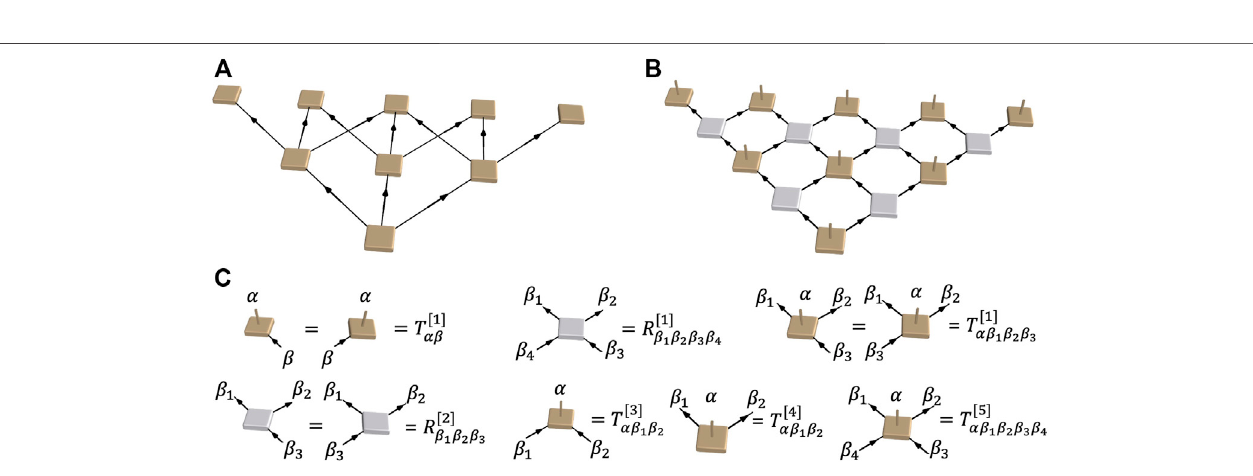
FIGURE 3 | Tensor network construction for open-pit mining problem. (A) Directed graph representation of the open-pit mining problem, with the excavatable blocksexpressed asnodes inlightbrown. (B) Acorrespondingtensornetworkconstruction, where thelightbrownblocks showthephysicalnodes and thegrayblocks show the virtual nodes. (C) The de fi nition of nonequivalent tensors in our tensor network construction. α and β represent the physical and virtual indices,